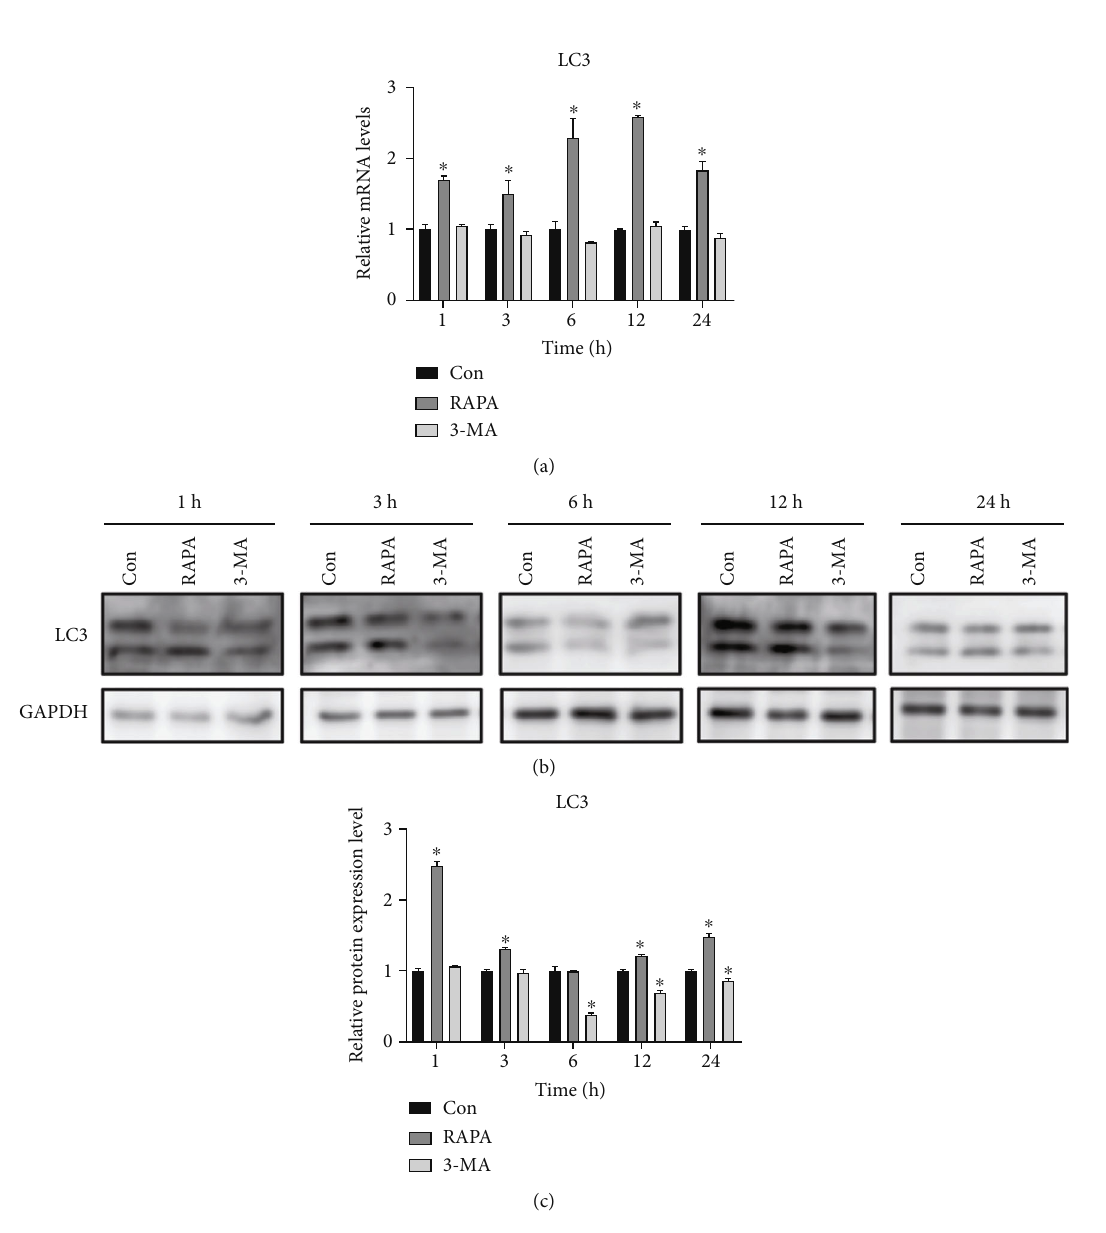
Figure 9: Drug regulation of the autophagy level. (a) LC3-relative mRNA expression levels assessed by real-time PCR in the control, RAPA, and 3-MA groups. (b) LC3-relative protein expression levels assessed by western blotting in the control, RAPA, and 3-MA groups. ∗ P < 0 : 05